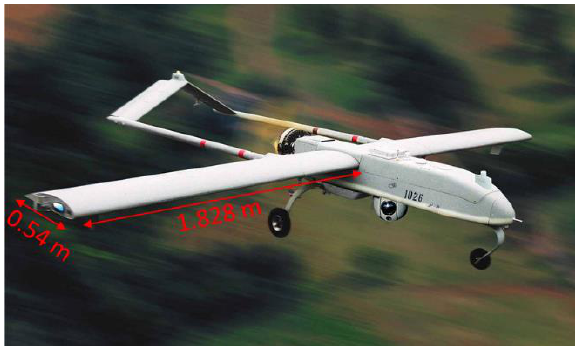
Figure 1. Selected UAV model RQ-7 shadow [38]. Table 1. Detail Specifications of RQ-7, Aircraft Model for Study.